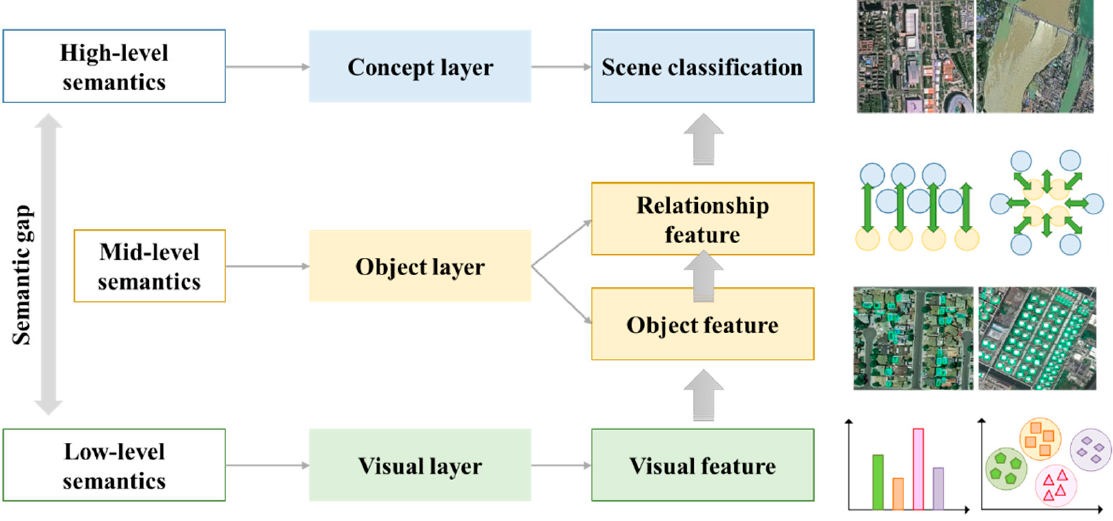
Figure 2. Semantic hierarchy model of three layers structure.